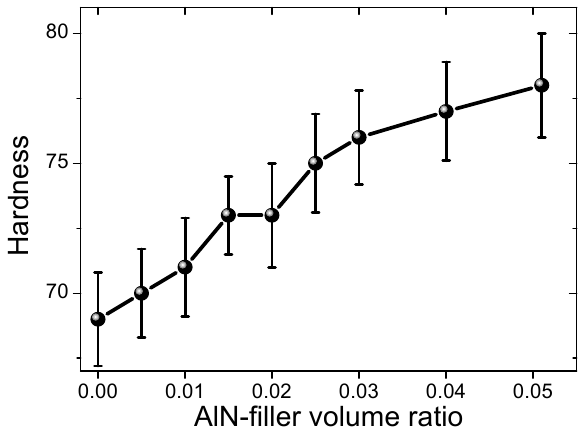
Figure 3. Shore hardness (HA) of the AlN-filled silicon rubber composite samples.